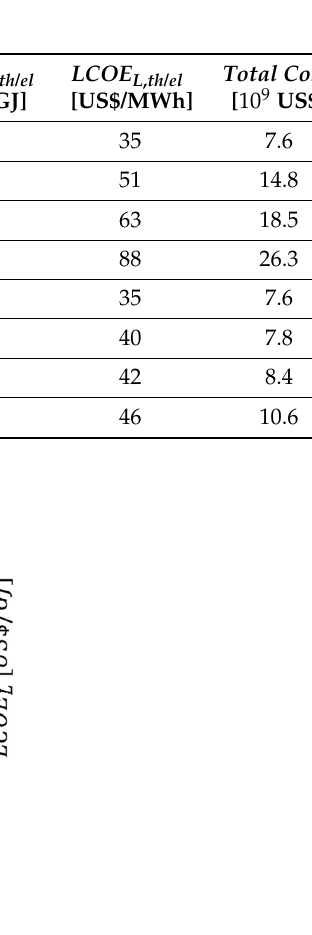
Table 9. Lower estimate for the LCOE under the assumption that all energy can be used or exported to the grid for each RES target .